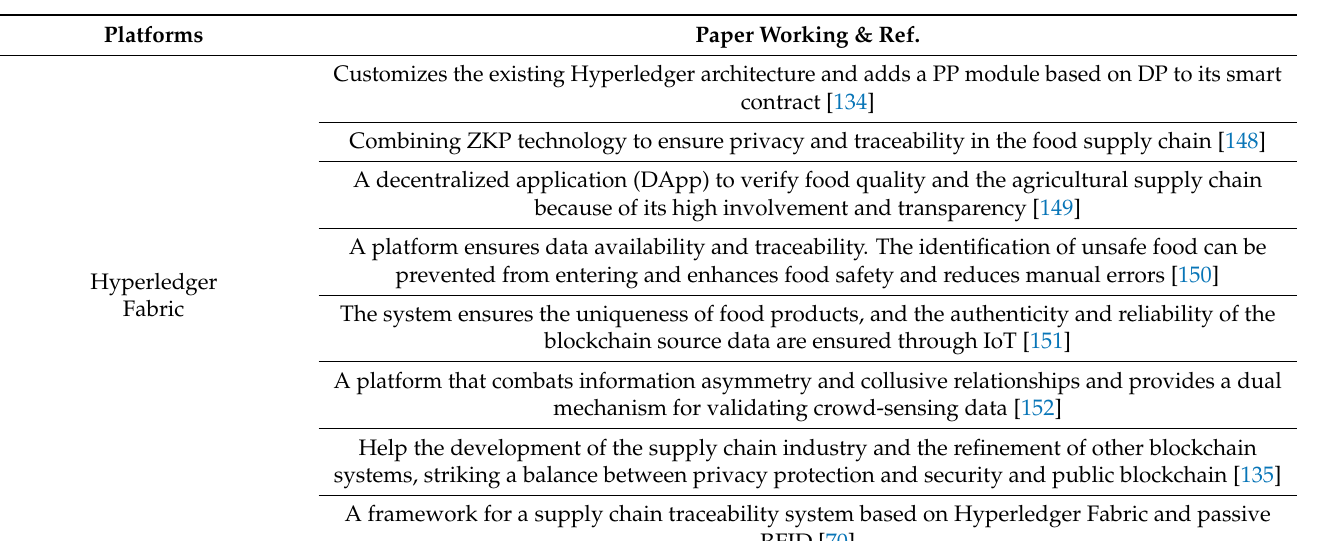
Table 7. Cont. Platforms Paper Working &